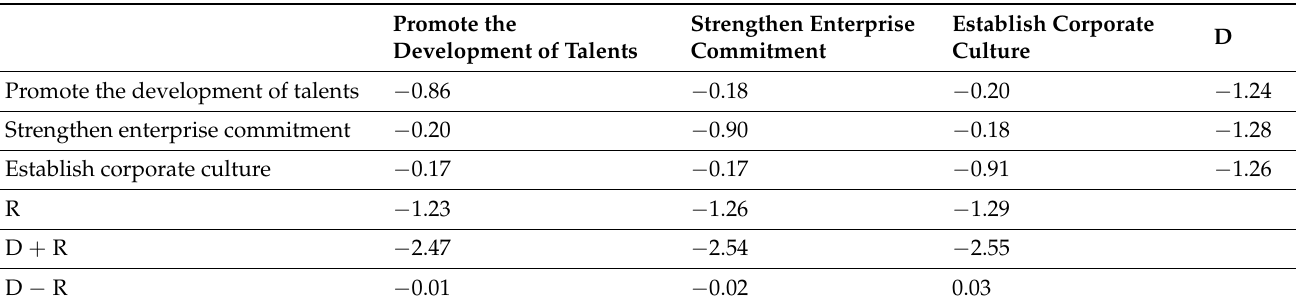
Establish Corporate Culture